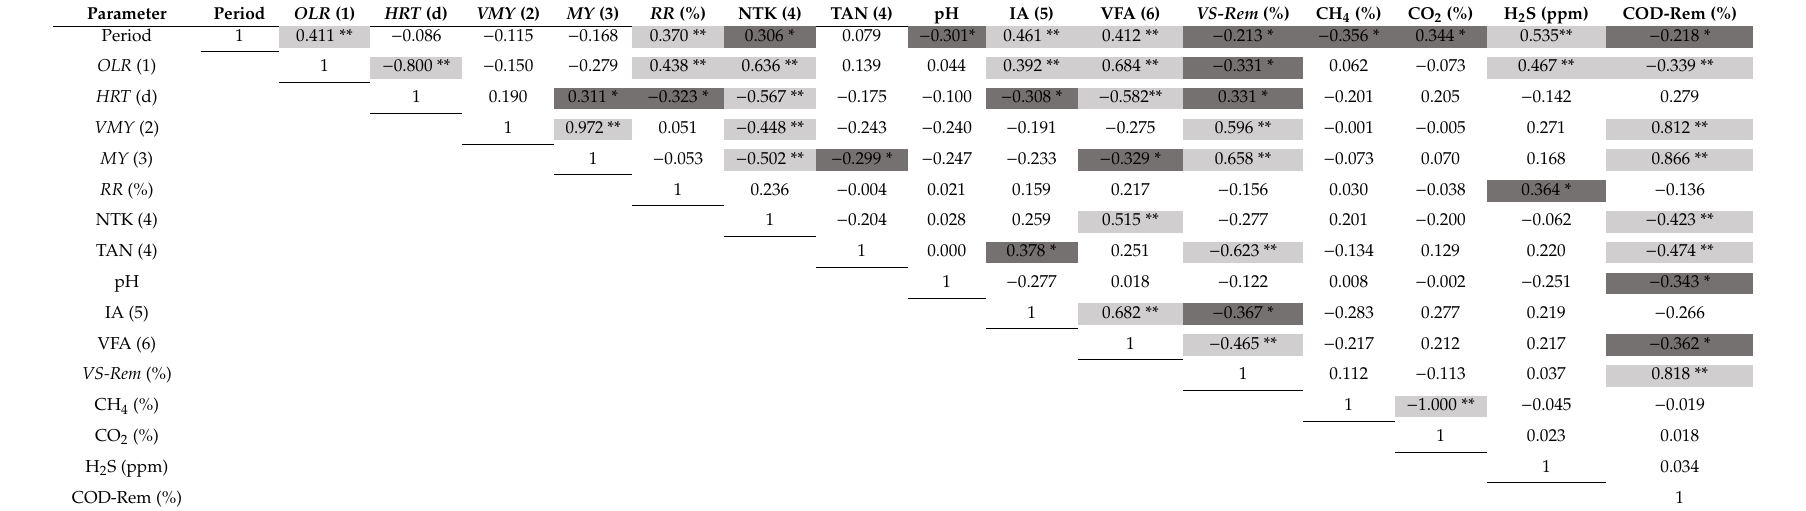
Table 4. Correlation coe ffi cients (Pearson coe ffi cients) for parameters. Note: * Significant correlation at 0.05 levels (dark grey). ** Significant correlation at 0.01